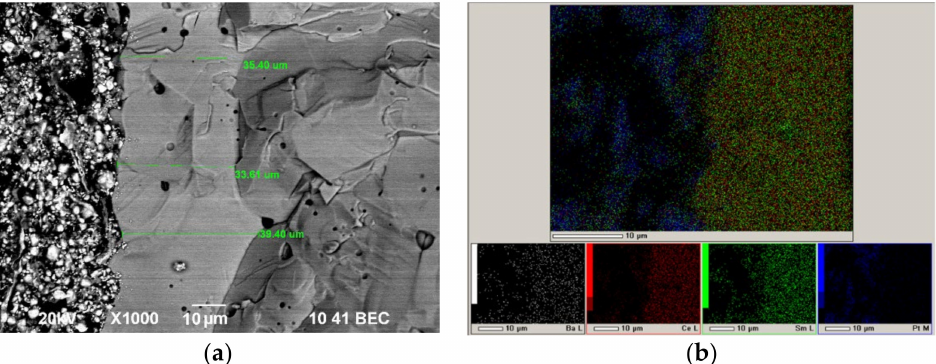
Figure 13. SEM analysis of the cell with the SDC-PPy-BCSCuO_1 electrolyte membrane with Pt electrodes after the measurement cycle: ( a ) Cross-sectional SEM image; ( b ) Integral and individual maps of the element